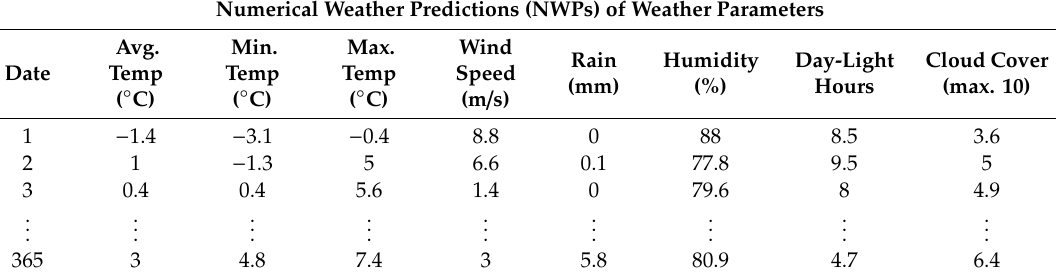
Table 1. Weather data used in the numerical simulation.